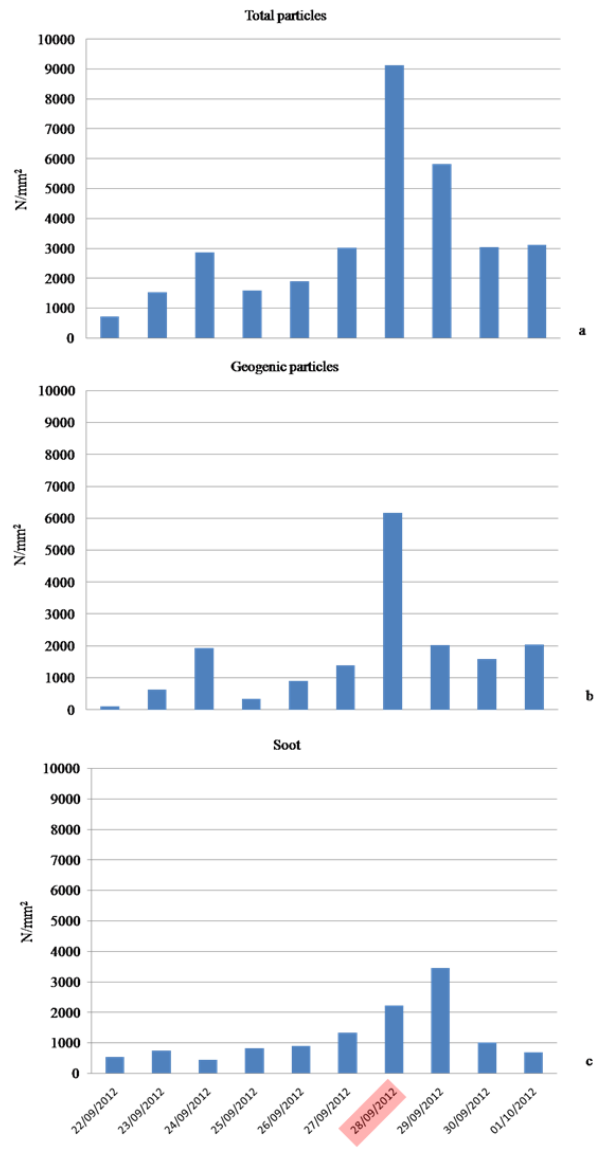
Figure 8. Surface concentration trends of total particles (a) , ge- ogenic particles (b) and soot (c) in the ≥ 0.7µm fraction. The flare event date is highlighted in red. The largest amounts of particles were observed on 28 September 2012, due to increased geogenic particle quantities. The highest soot surface densities on the fil- ters were identified on the day after the flare at C.O.V.A., but soot amounts had been significantly increasing since 25 September, long before the event.